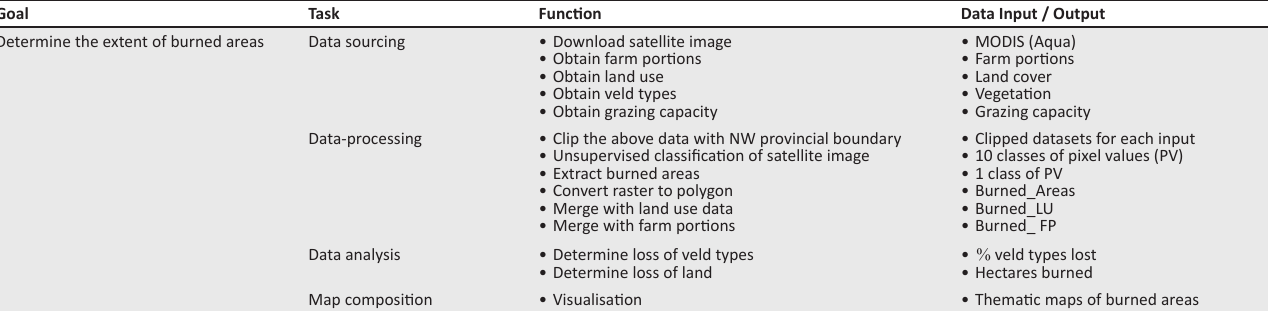
TABLE 1: Example of Geographical Information Systems spatial operations associated with a functional goal.